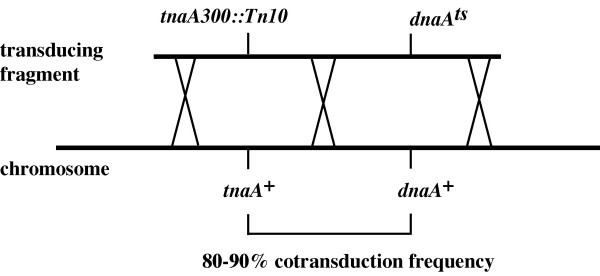
The tnaA- dnaA region of the E. coli chromosome is diagramed on the lower line. The upper line is symbolic of the DNA introduced by the P1 transduction in the standard cross described in this paper where a tnaA300::Tn10 dnaAts donor is introduced to a dnaA+ recipient. Potential crossover events between the two markers are shown.